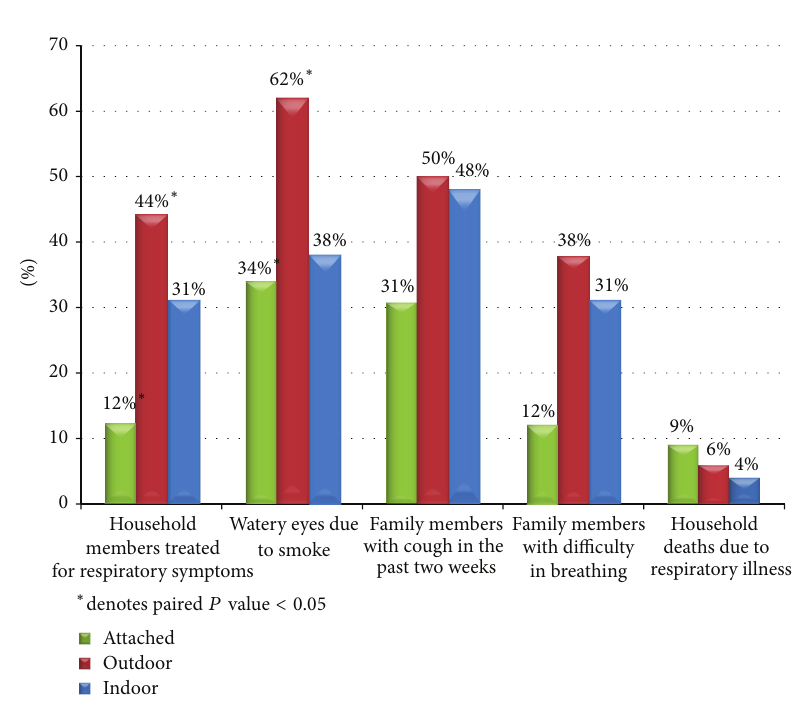
Figure 3: Comparison of respiratory symptoms by stove